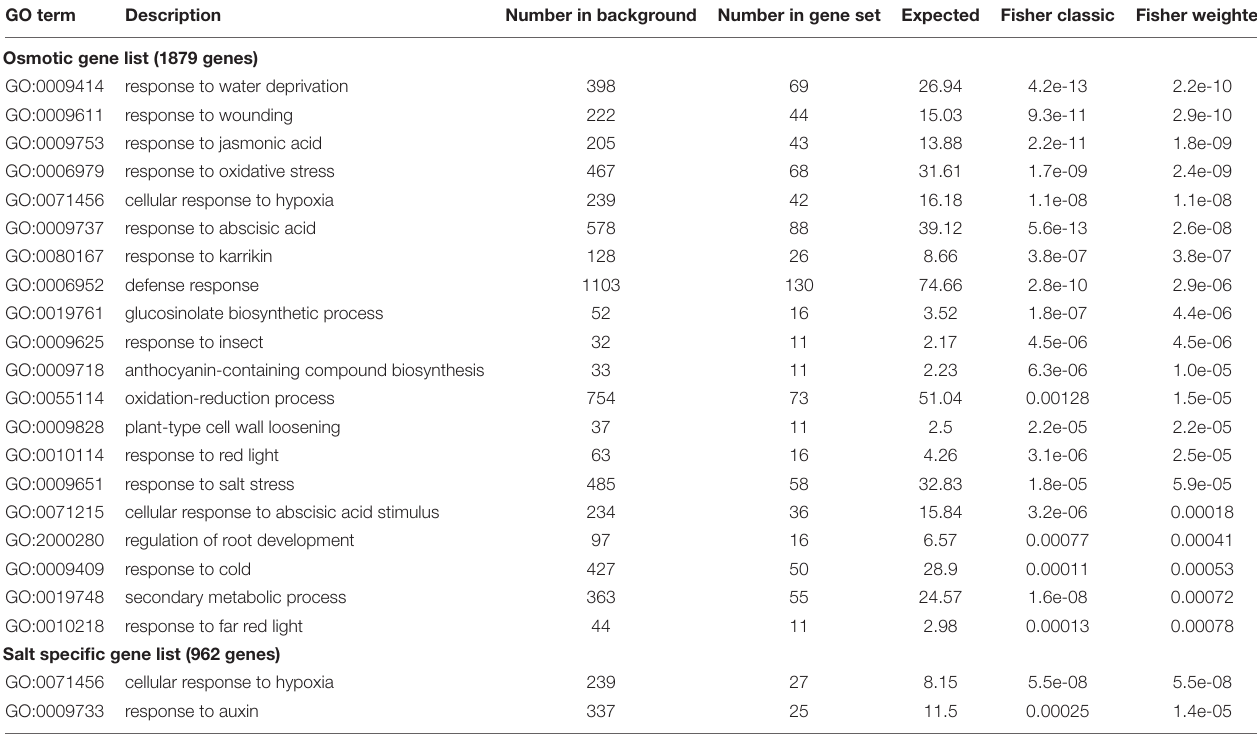
TABLE 1 | The Gene Ontology (GO) terms enriched in the osmotic and salt-specific gene lists. GO term